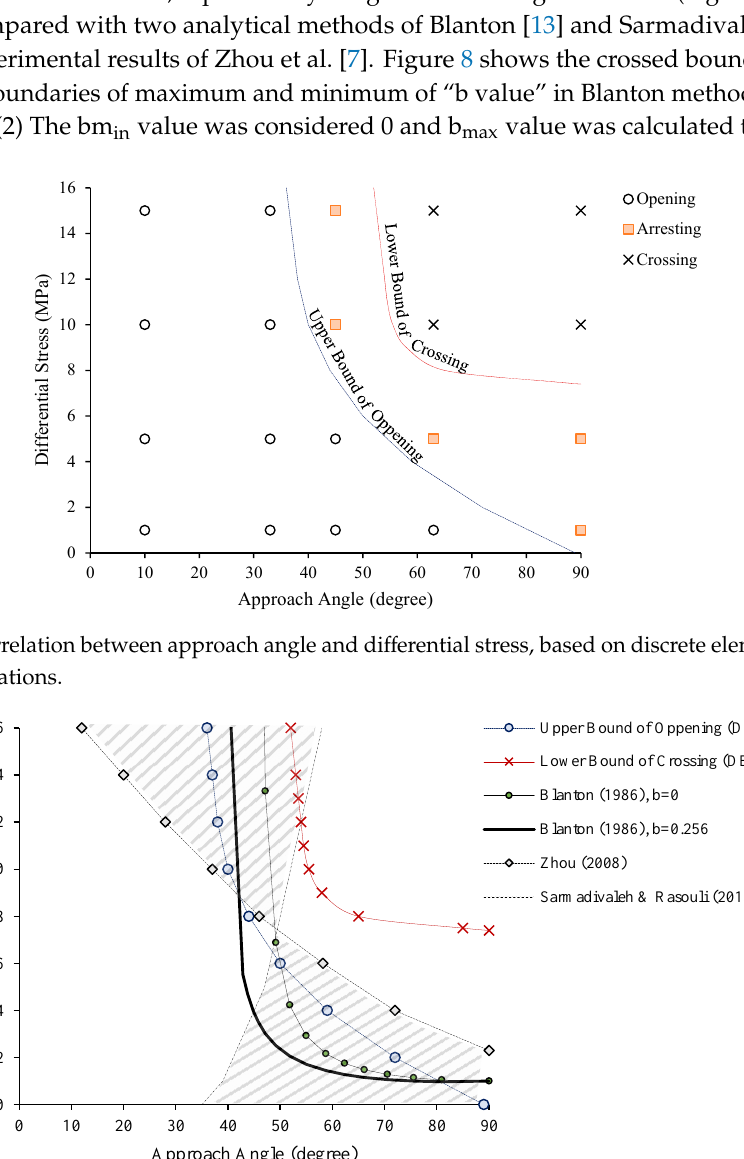
8 of 13 Figure 6. Crossing mode in numerical modeling with an incidence angle of 90 degrees under differential stresses of 15 MPa 3.3. Comparison Different Methods The boundary of three regions of interaction modes was determined based on numerical simulation